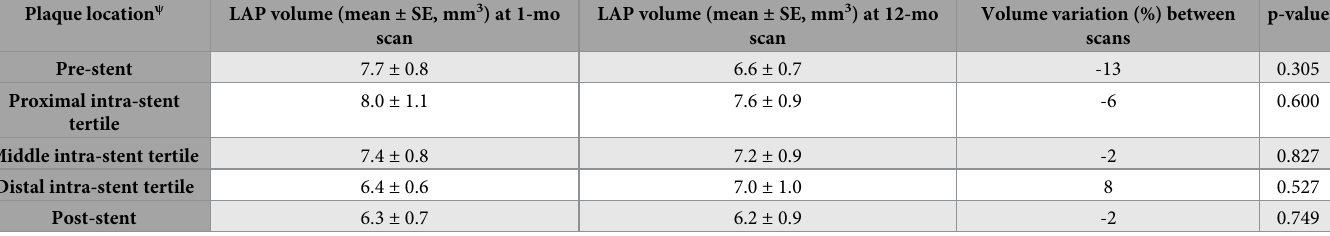
Table 9. Absolute LAP volume at 1- and 12-month follow-up by plaque location (pre-, 1 st , 2 nd , 3 rd intra-stent tertiles, and post-stent blocks). Plaque location